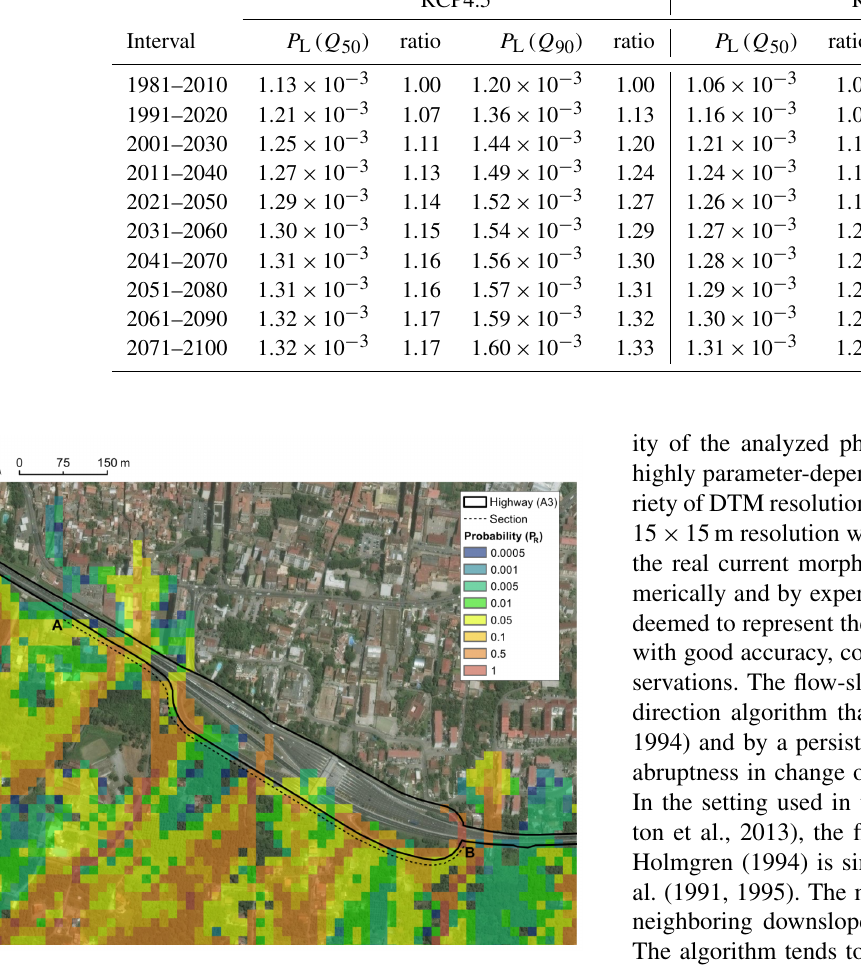
Table 4. Temporal evolution of occurrence probability for RCP4.5 and RCP8.5 (50th and 90th quantiles). RCP4.5 RCP8.5